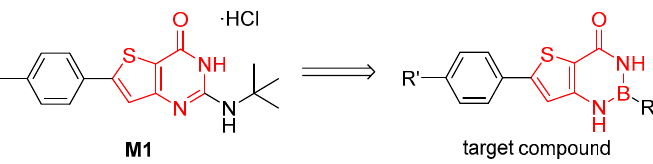
Scheme 1. Scaffold hopping strategy for compound M1.